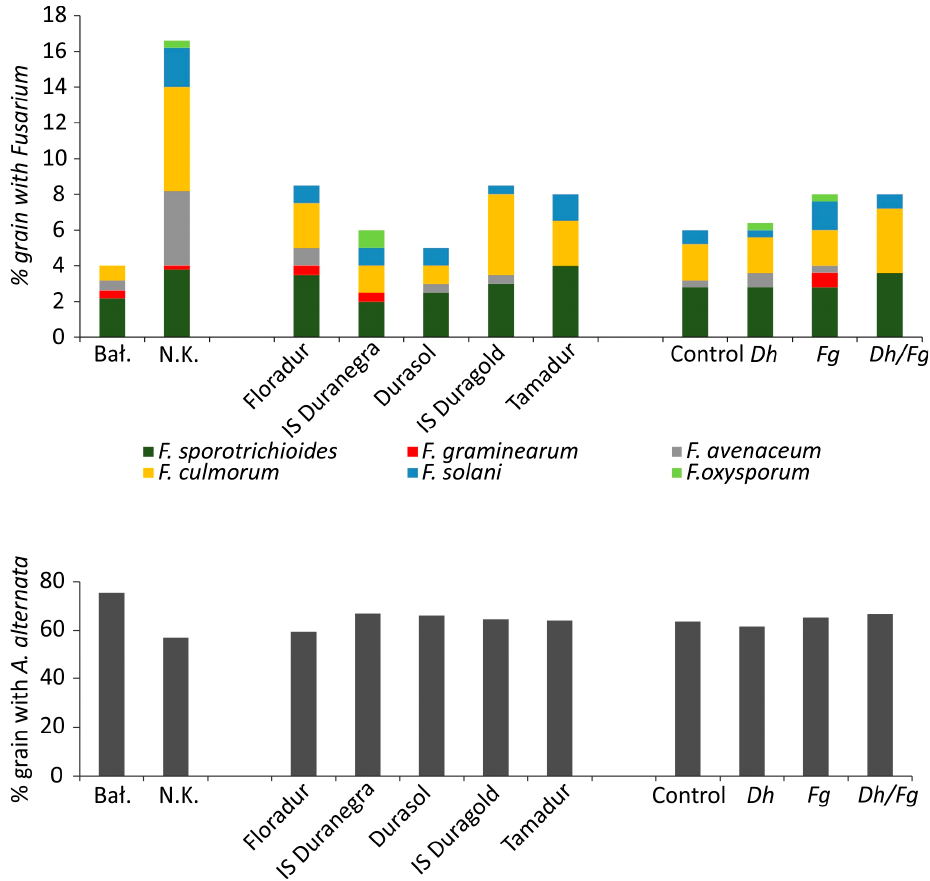
Figure 4. Percentage of kernels colonized by Fusarium and Alternaria spp. species across locations, cultivars, and protective treatments. Ba ł —Ba ł cyny, N.K.—Niedrzwica Ko ś cielna, Fg— inoculation cultivars, and protective treatments. Bał—Bałcyny, N.K.—Niedrzwica Ko´scielna, Fg —inoculation with Fusarium graminearum, Dh —biocontrol with Debaryomyces hansenii , Dh/Fg —biocontrol with D. with Fusarium graminearum , Dh —biocontrol with Debaryomyces hansenii , Dh/Fg —biocontrol with D. hansenii + inoculation with F. graminearum. hansenii + inoculation with F. graminearum